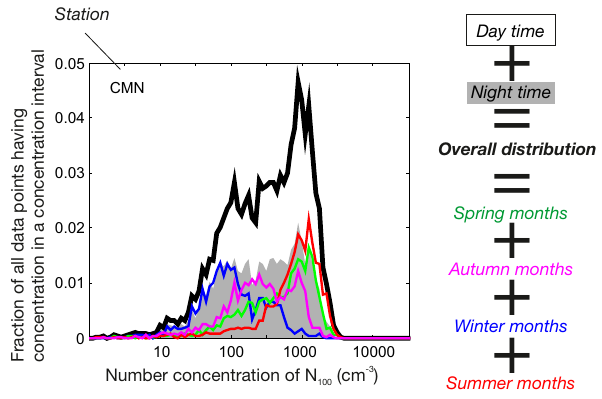
Fig. 8. Example of the number concentration histograms used in Figs. 9–11. The black line shows the histogram (with equal log distributed bins) of all available data from the station. The seasonal histograms are normalized to total amount of available data; they sum up to the total histogram value. The shaded area shows the similarly normalized histogram of only night-time samples. The white area above is the fraction of the total histogram which was from the day-time